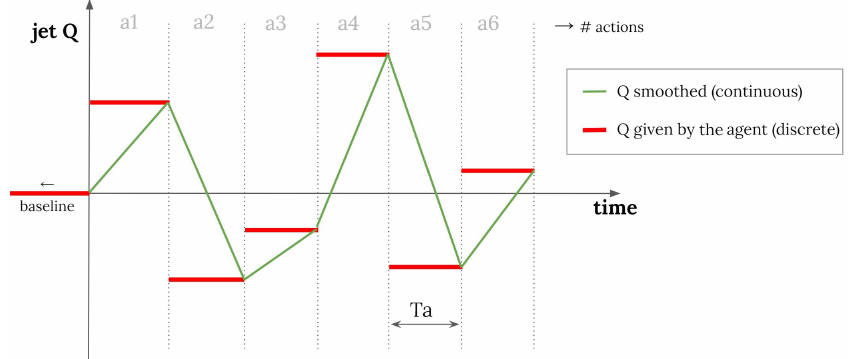
Figure 4. Flow rate of the jet Q smoothed and applied in the numerical simulation (green) versus the discrete Q decided by the DRL agent